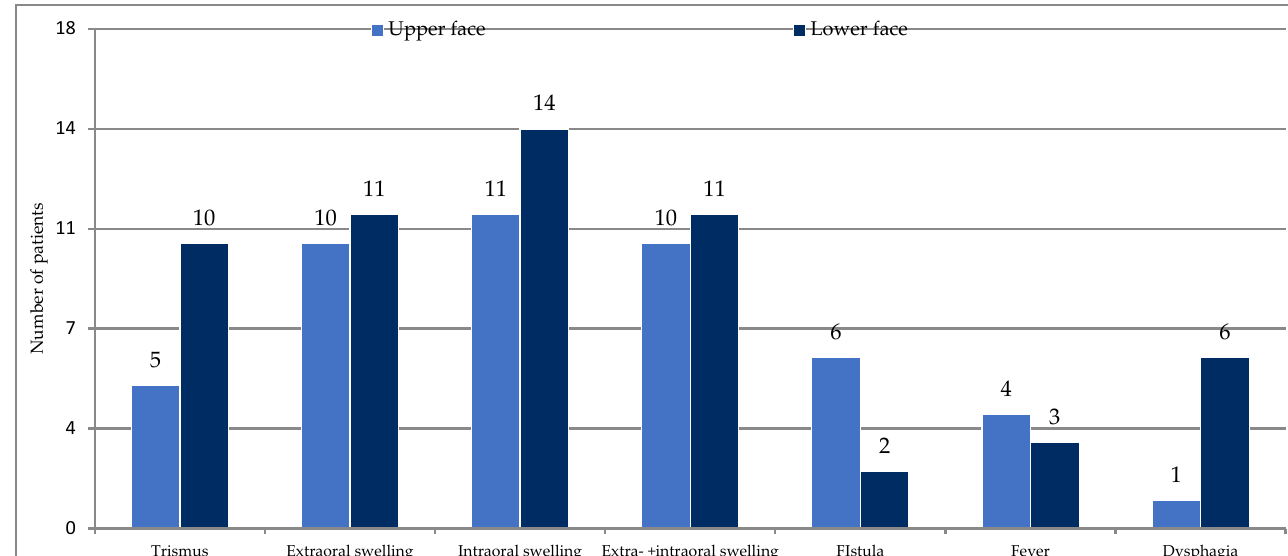
Figure 2. Lower face-source of infection (n = 14).